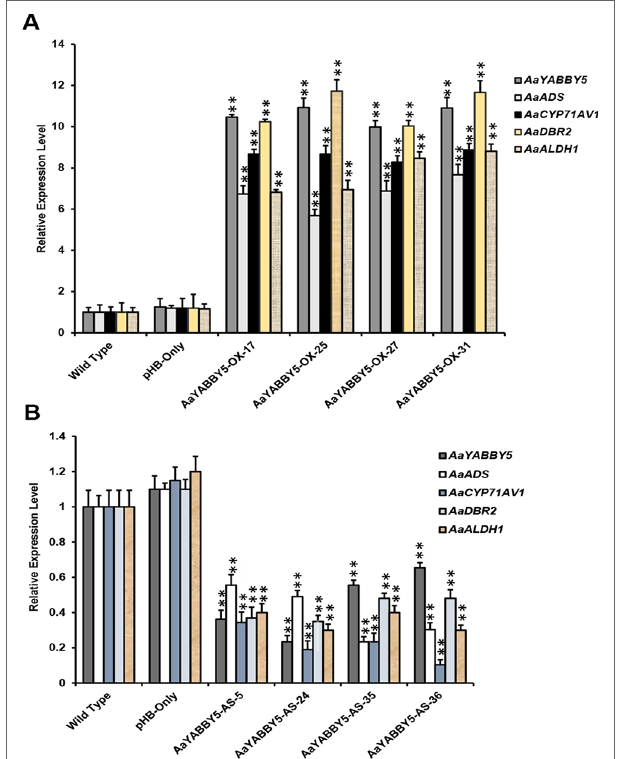
FIGURE 7 | Relative expression analysis of AaYABBY5 , ADS , CYP71AV1 , DBR2 , and ALDH1 in AaYABBY5 overexpression and AaYABBY5 antisense Artemisia annua . (A) Expression of AaYABBY5 , ADS , CYP71AV1 , DBR2 , and ALDH1 in selected AaYABBY5 overexpression A. annua . β -Actin was used as an internal control of each gene. Values represent mean ± SD of three experimental replicates. Error bars represent standard deviation for n =